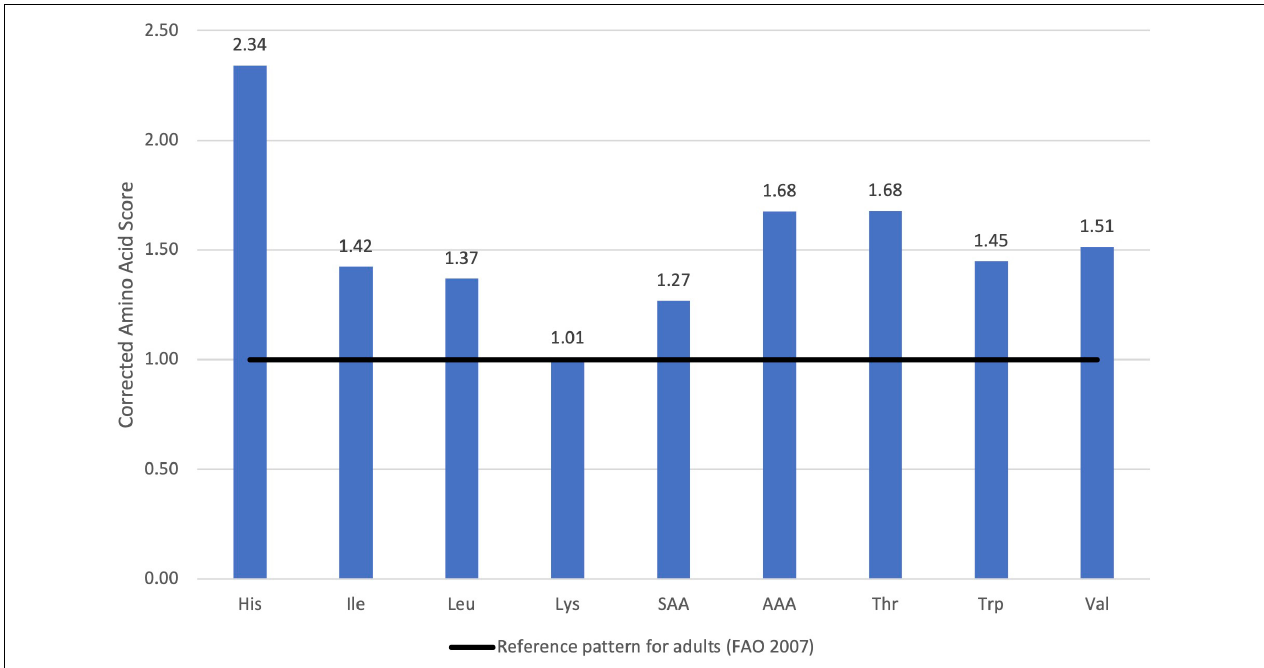
FIGURE 4 | Corrected Amino Acid Score of optimized formula for oat drink.